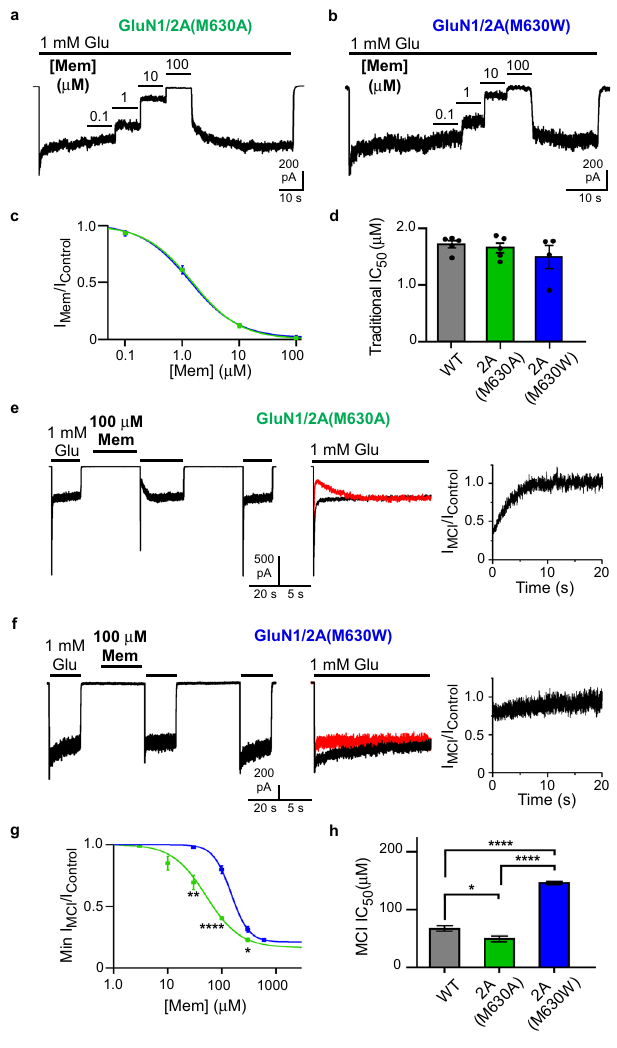
Fig. 6e, g, h), whereas mutation GluN2A(M630W) increased